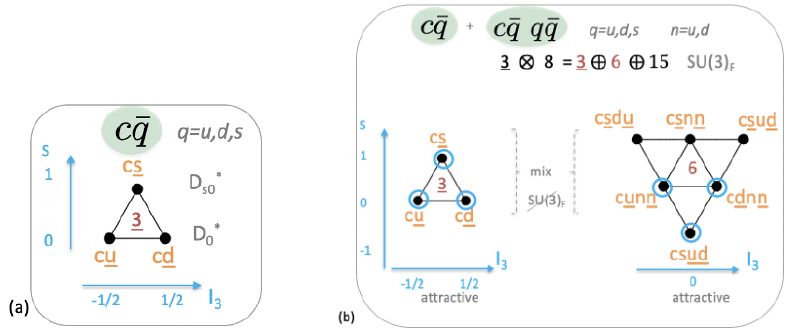
Figure 12. The flavor contents of the scalar charmed mesons according to the quark model (a) and the new paradigm (b).